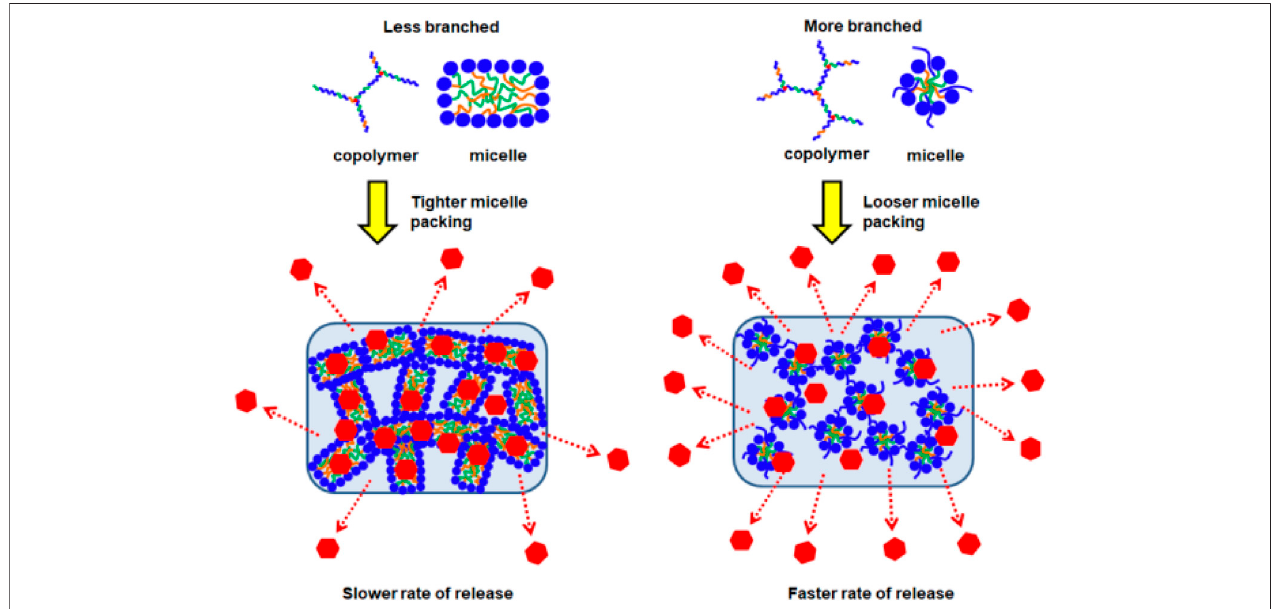
FIGURE 7 | Schematic representation of EPCG copolymers micellar packing into supramolecular hydrogels followed by the release of incorporated drugs; higher degree of branching leads to looser micellar packing and subsequent faster rate of release.